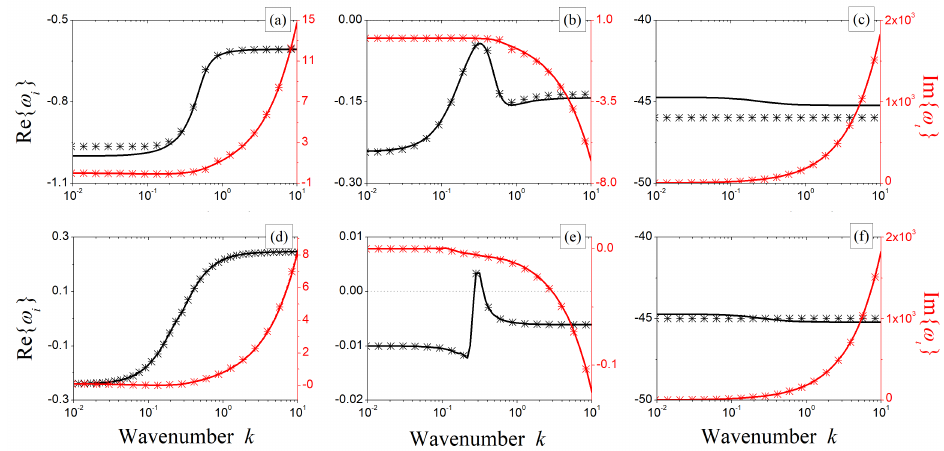
Figure 4. Comparison between numerically computed (solid lines) and theoretically estimated (symbols) roots of the complex characteristic Equation (6) when evaluated at the points P 1 (panels ( a – c )) and P 2 (panels ( d – f )). The real parts are depicted in black, whereas the imaginary ones are depicted in red. Root ω 1 is represented in panels ( a , d ); ω 2 is depicted in ( b , e ), and ω 3 is depicted in ( c , f ). Fixed parameters: ψ = 0.8, A = 1.7, and B =